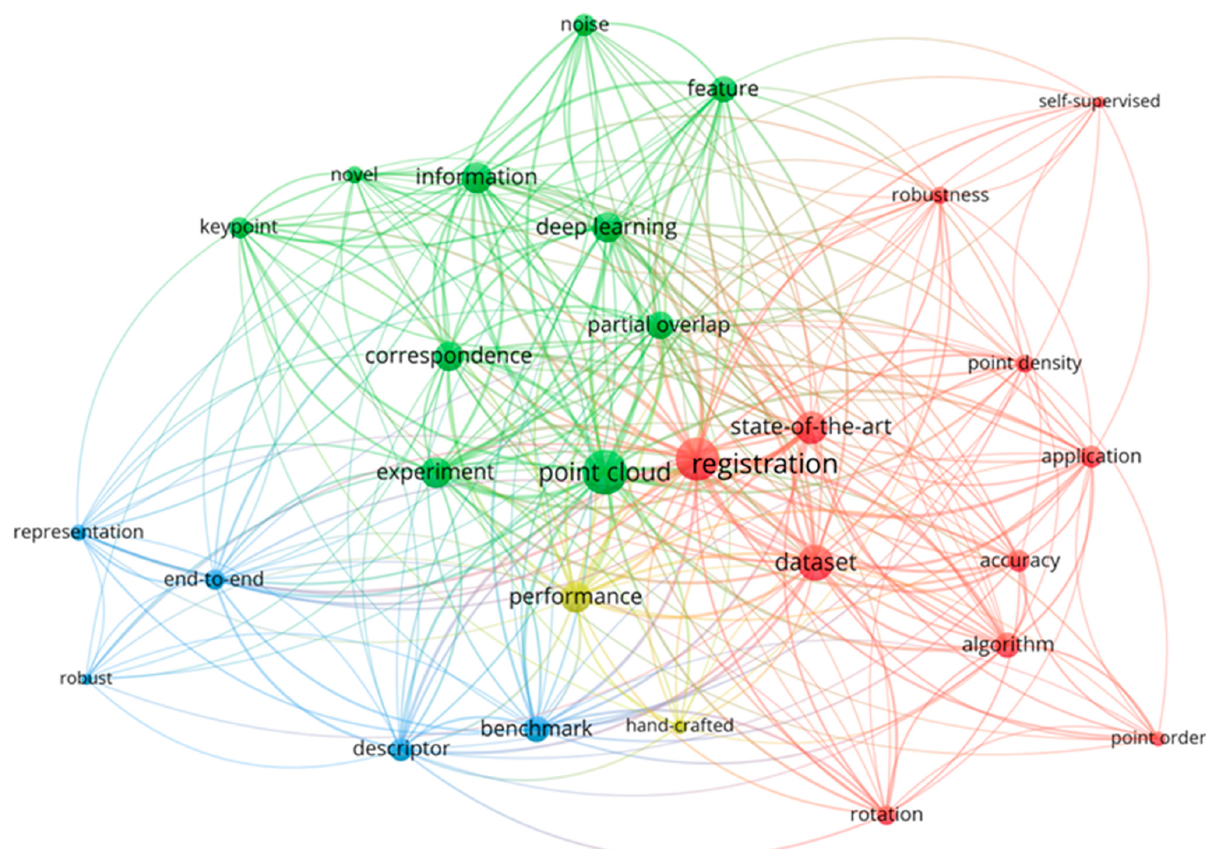
Figure 3. Keyword network of the surveyed literature.